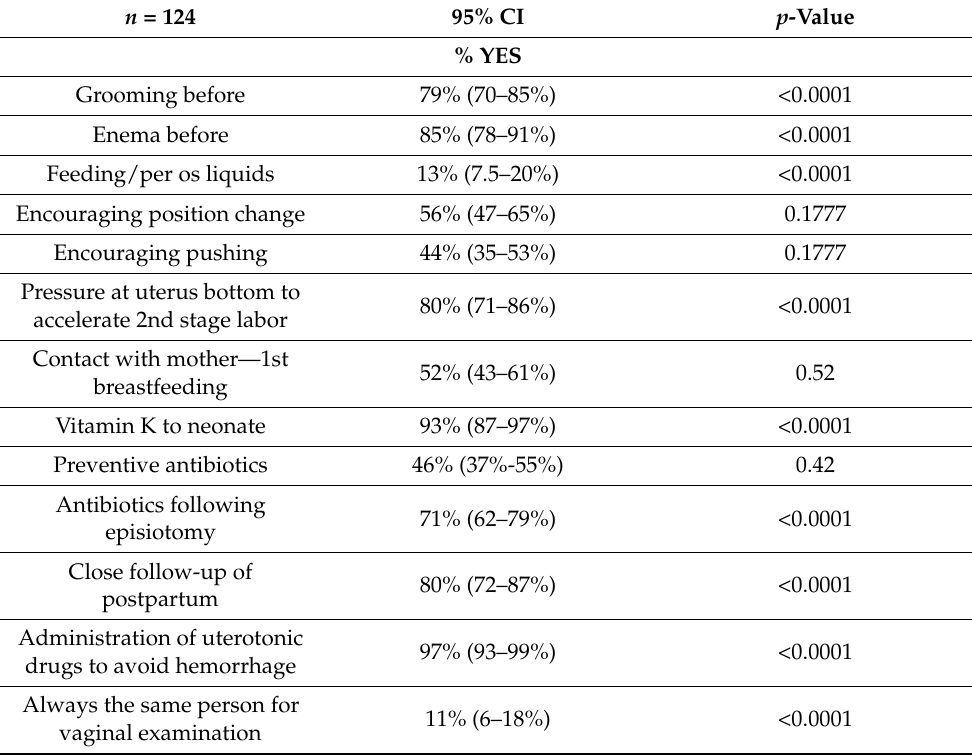
Table 2. Affirmative answers regarding the application of midwifery